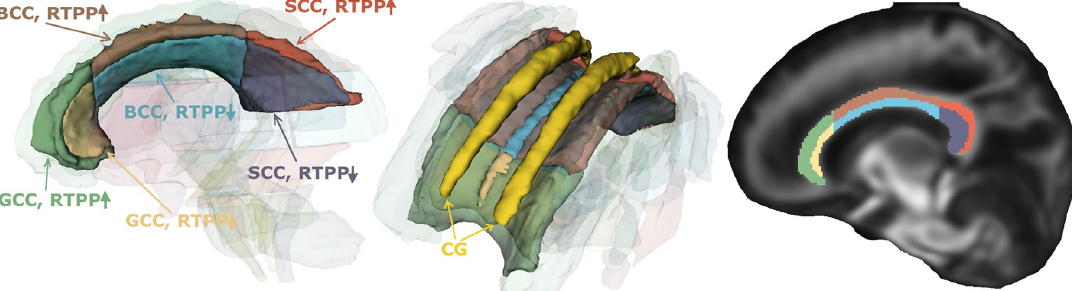
Fig 5. Average segmentation of the corpus callosum in the space of the ENIGMA template by AMURA-RTPP thresholding at 27 mm − 1 . The cingulum (CG) is also rendered in the 3D view for reference purposes. A sagittal slice of the average FA of the PDD is also shown for